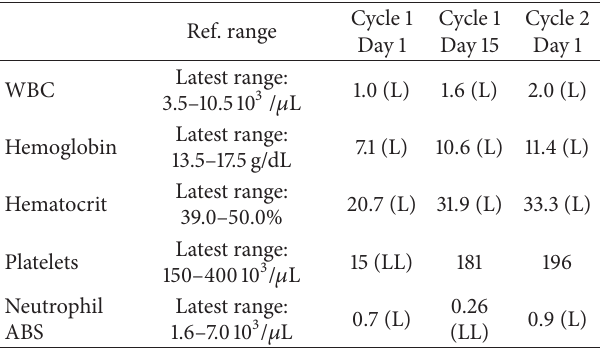
Figure 3: Hemophagocytosis consistent with HLH was noted in the bone aspirate smears. Table 1: Patient’s improving lab values following two cycles of ABVD